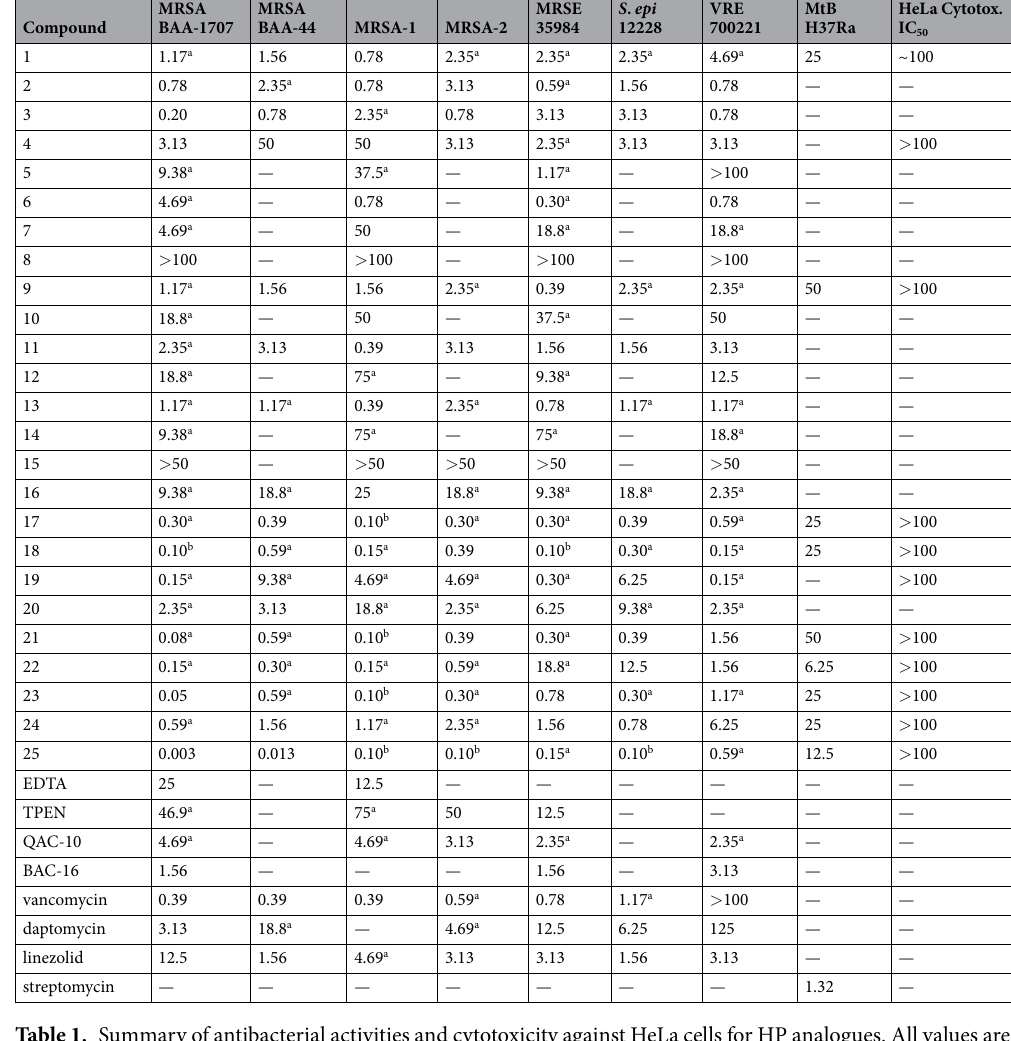
Table 1. Summary of antibacterial activities and cytotoxicity against HeLa cells for HP analogues. All values are reported in micromolar ( µ M) concentrations. Note: a Midpoint for a 2-fold range in observed values. b Lowest concentration tested. All biological results were generated from three independent experiments.